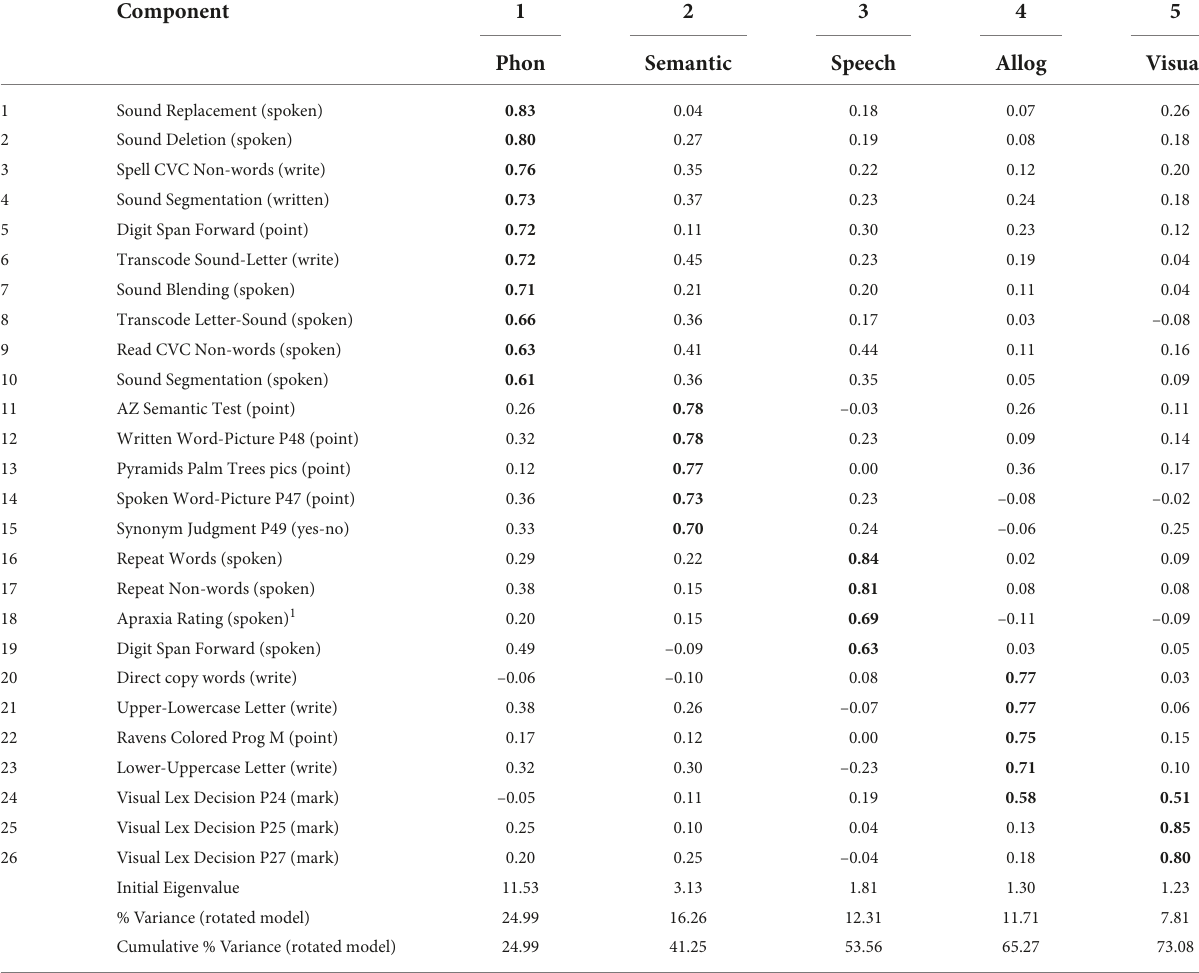
TABLE 5 Results from principal components analysis implemented using 26 scores from 85 language-impaired individuals.